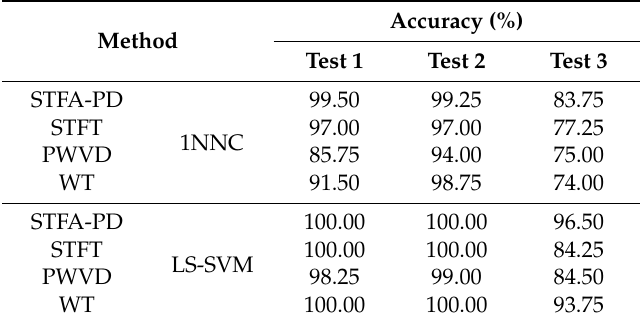
Table 2. Results of bearing fault severity